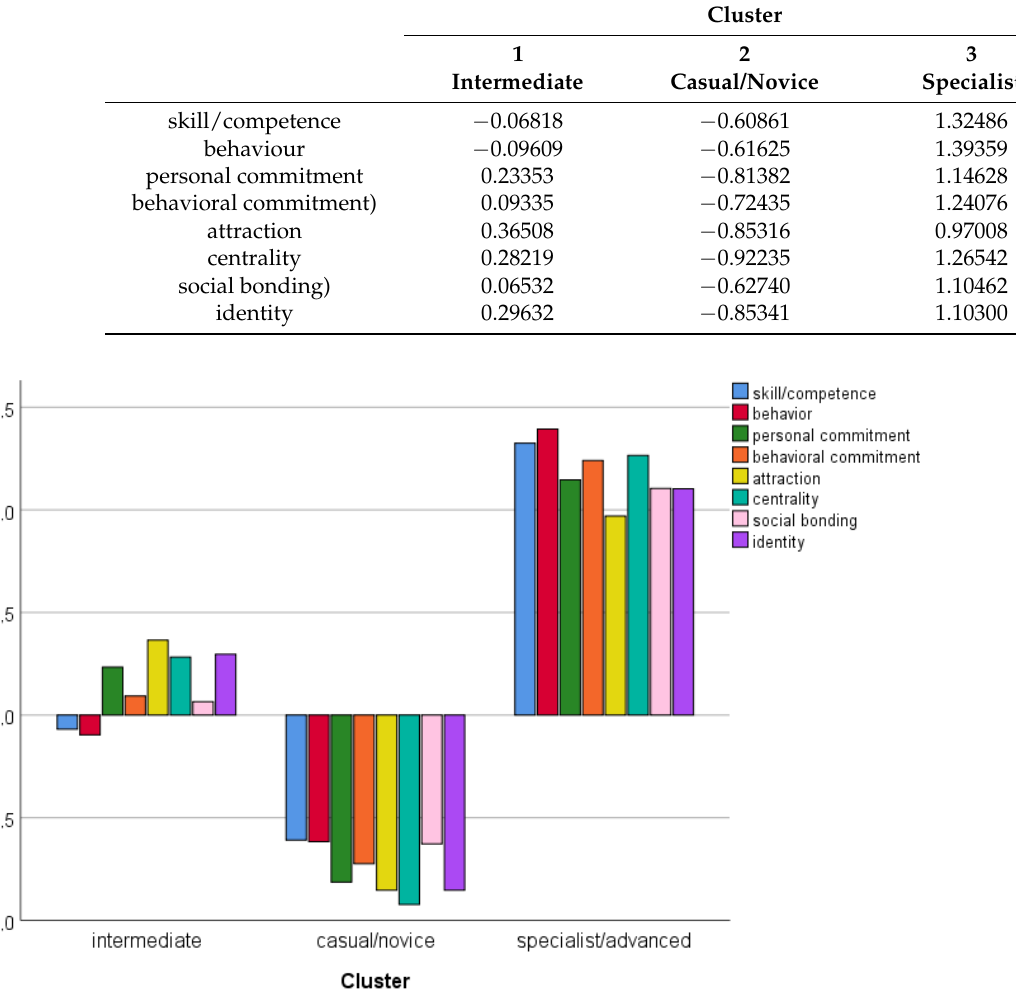
Figure 1. Distribution of the scores of the eight continuous measures of birding specialization (see legend) according to the three clusters. A higher value represents a higher specialization.